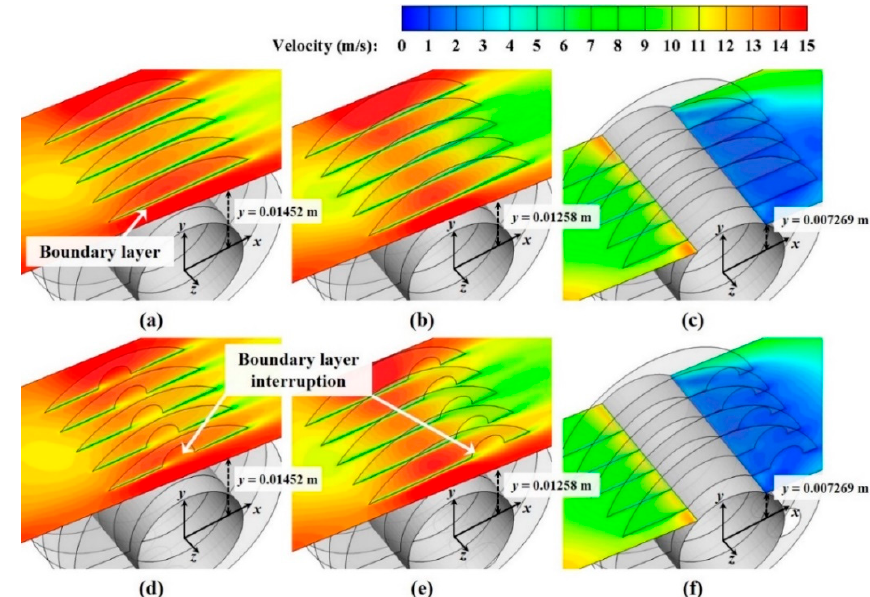
Figure 6. Velocity magnitude distributions with different hole locations at Re = 11,440. ( a ) Case 1(ref.) at y = 0.01452 m; ( b ) Case 1(ref.) at y = 0.01258 m; ( c ) Case 1(ref.) at y = 0.007269 m; ( d ) Case 2 at y = 0.01452 m; ( e ) Case 3 at y = 0.01258 m; and ( f ) Case 4 at y = 0.007269 m.